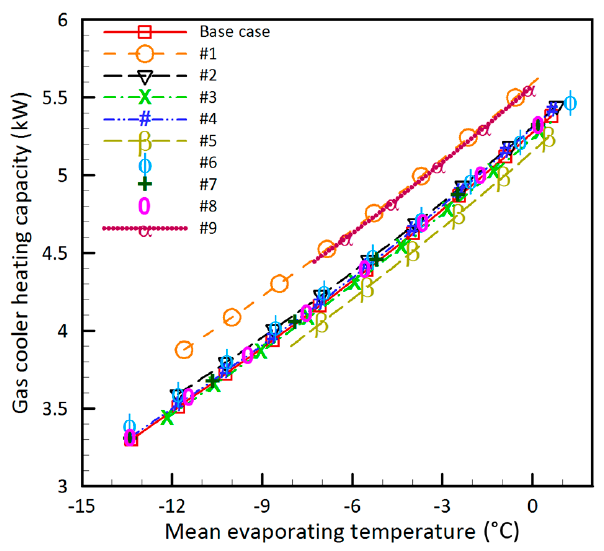
Figure 7. Discharge pressure ( P discharge_comp ).